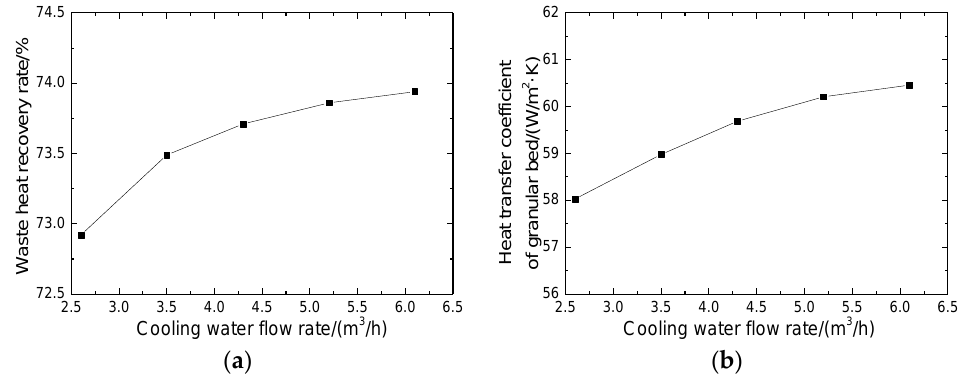
Figure 11. Influence of cooling water flow rate on the heat transfer in granular bed. ( a ) Influence on the waste heat recovery rate. ( b ) Influence on the heat transfer coefficient.